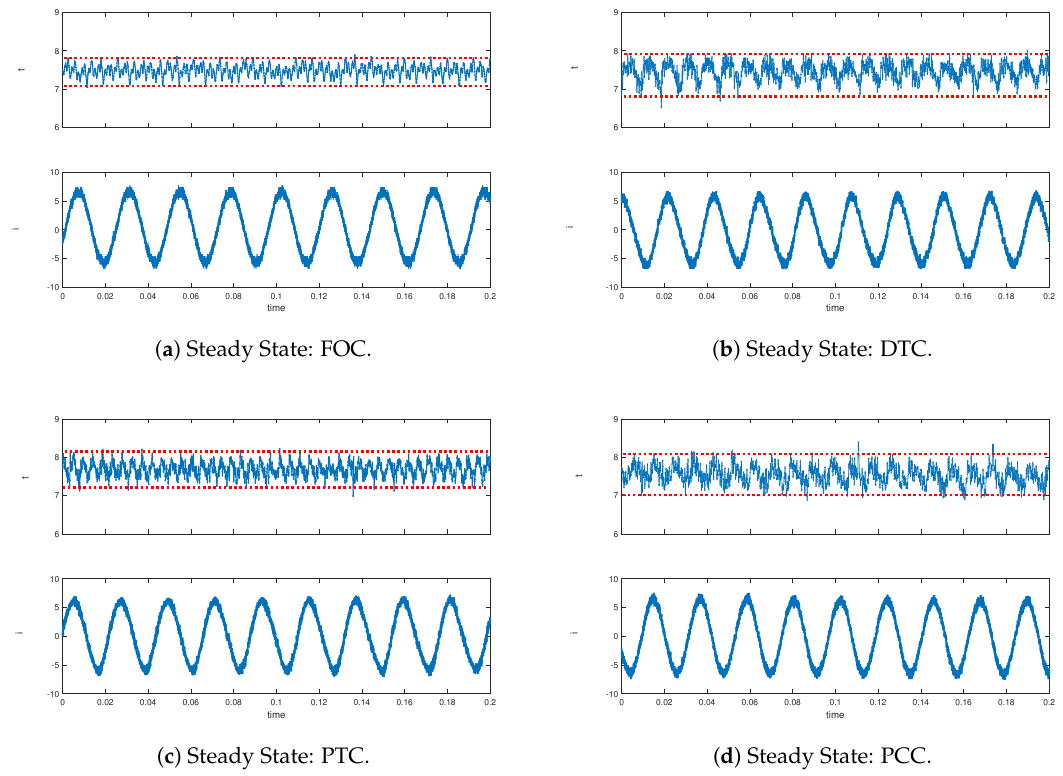
Figure 3. Experimental results: Torque and Stator Current behaviors of four